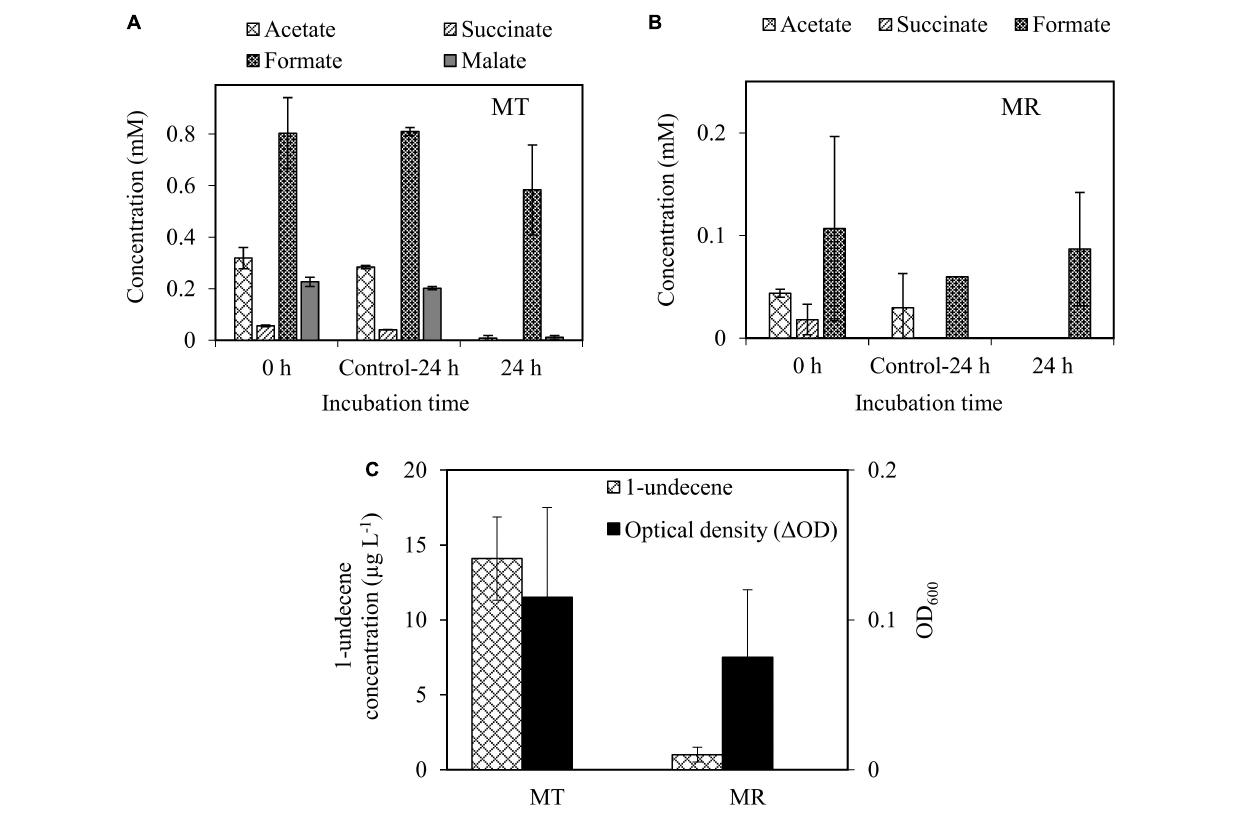
FIGURE 6 | Organic acid utilization by A. baylyi ADP1 ‘tesA - undA in spent media obtained from the cultivation of M. tundripaludum SV96 (MT) (A) and M. rosea SV97 (MR) (B) under O 2 -limiting conditions. Growth and 1-undecene production from A. baylyi ADP1 ‘ tesA - undA after 24-h incubation (C) . (cid:49) OD indicates the difference in OD 600nm of A. baylyi ADP1 ‘ tesA - undA between 0 and 24 h. Error bars indicate the standard deviation of four replicate samples. The spent media from methanotrophs fermentation without A. baylyi ADP1 were used as control (Control-24